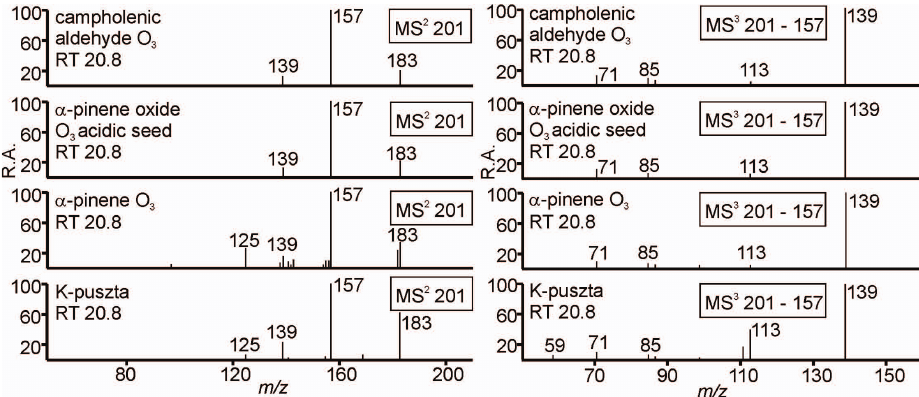
Fig. 8. MS 2 and MS 3 product ion spectra for the m / z 201